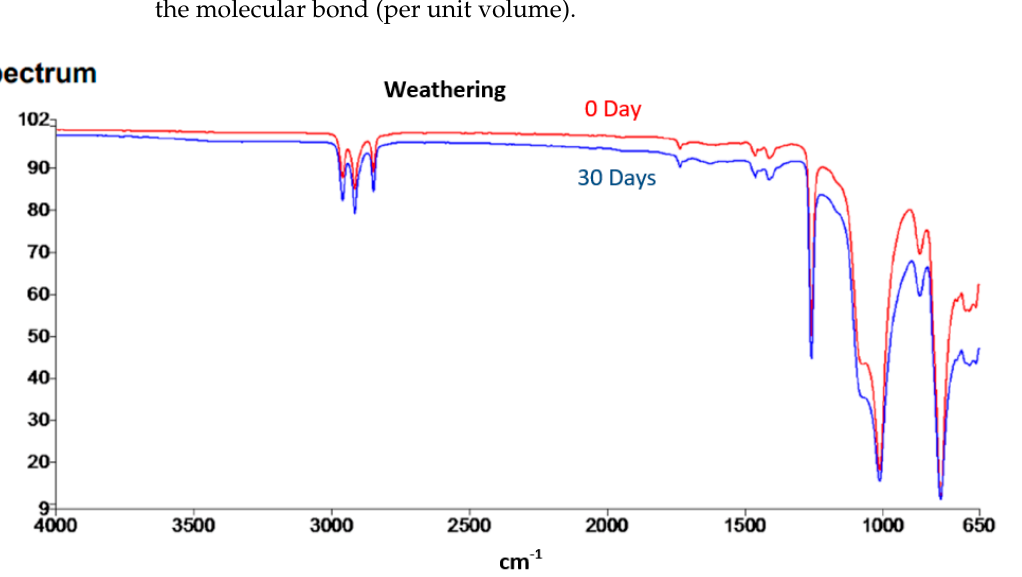
Figure 3. FTIR Spectral of MRE under natural weathering.